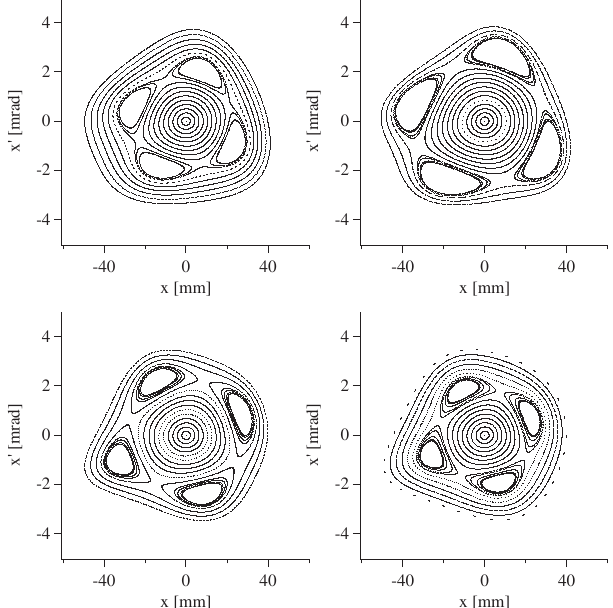
FIG. 5. Upper left: Phase space portrait corresponding to the PS configuration used in the experimental studies without space ¼ 6 . 255 . Upper right: Phase < 0 and Q charge effects, with h 2 ; 0 x space portrait corresponding to the configuration of upper left plot including five equally charged beamlets for a total intensity of 3 . 28 × 10 13 p. Lower left: Phase space portrait corresponding to a special PS configuration used only for the numerical > 0 and simulations without space charge effects, with h 2 ; 0 ¼ 6 . 245 . Lower right: Phase space portrait corresponding Q x to the configuration of the lower left plot including five equally charged beamlets for a total intensity of 1 . 31 × 10 13 p. Parallel plates electric boundary conditions are included. The beam momentum is 14 GeV =c